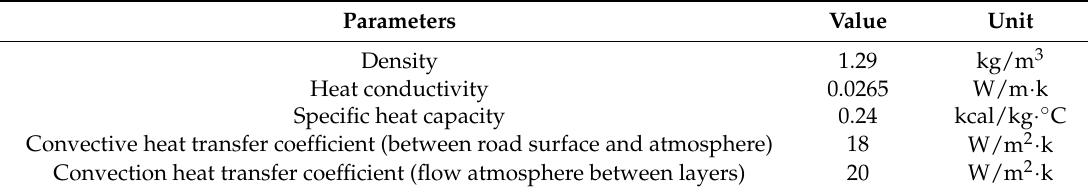
Table 4. Atmosphere parameters of the